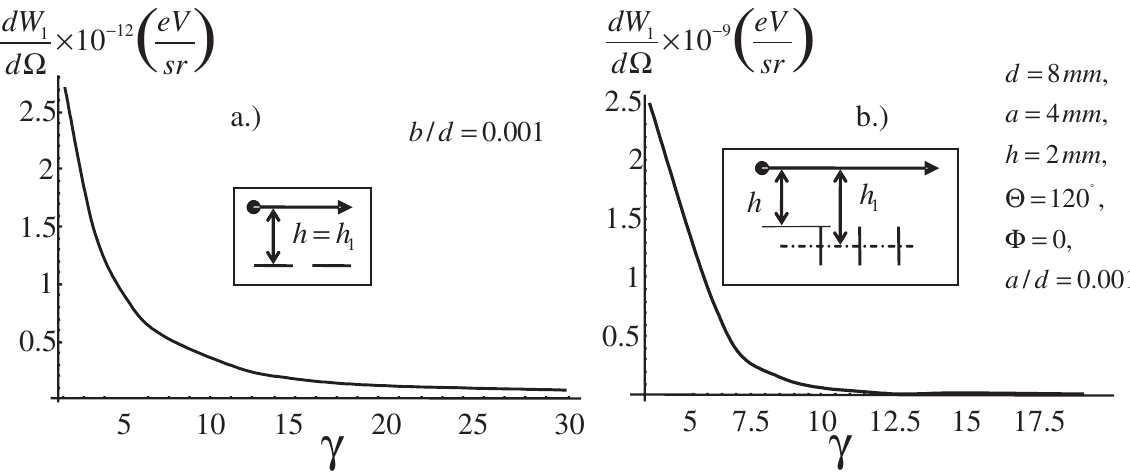
FIG. 13. Dependence of the SPR intensity on the Lorentz factor according to van den Berg’s model: (a) for a flat grating; (b) for a vertical strip grating.